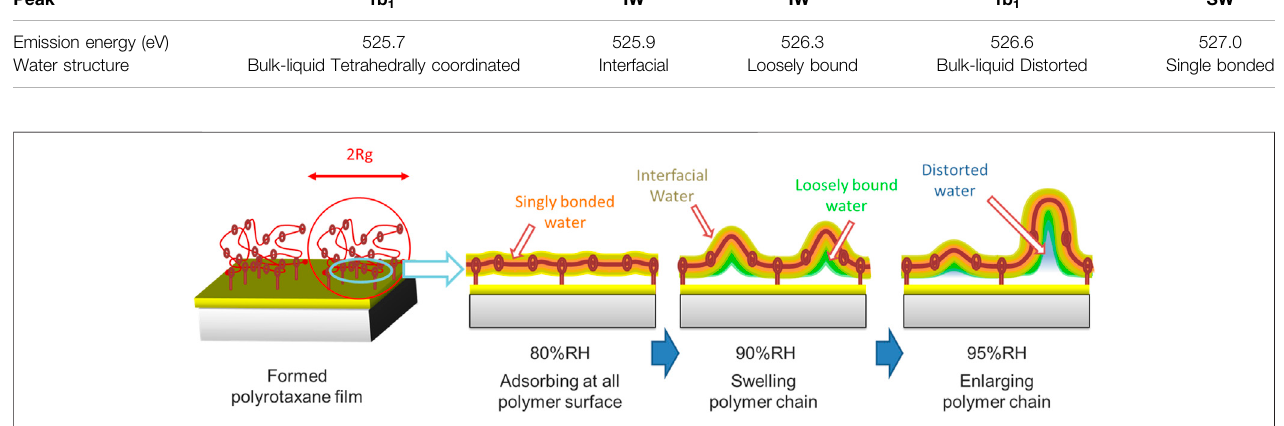
TABLE 1 | Detailed peak assignments of the 1b 1 peak corresponding to each combination of energy and water structure.